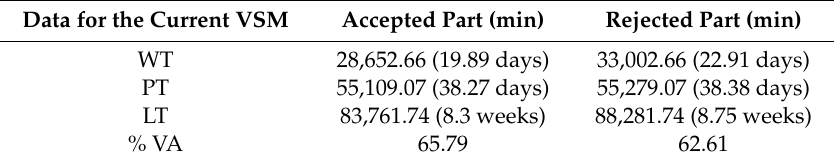
Table 4. Summary of data for the current